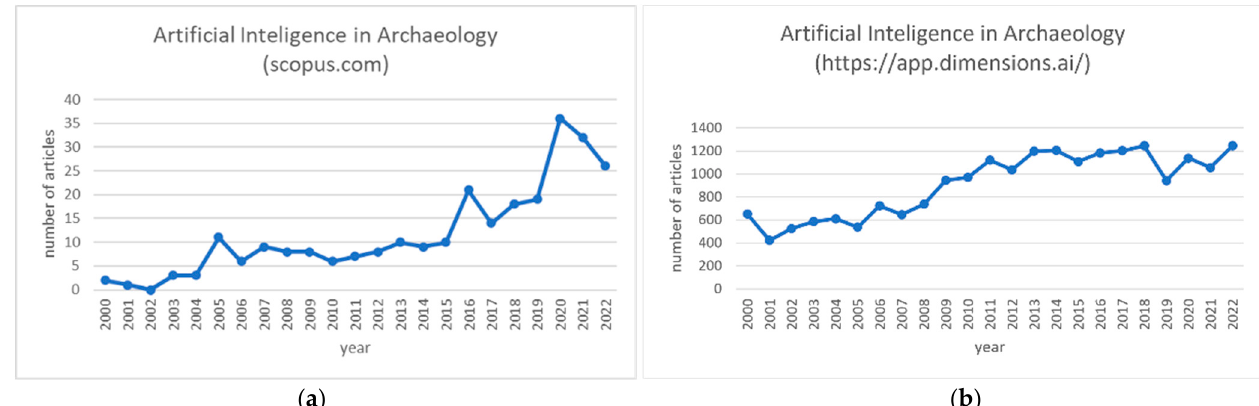
Figure 10. Annual publications of artificial intelligence in archaeology since 2000 (a) source: Sco- pus.com, (accessed on 15 October 2022), (b) source: https://www.dimensions.ai (accessed on 10 No- vember 2022).